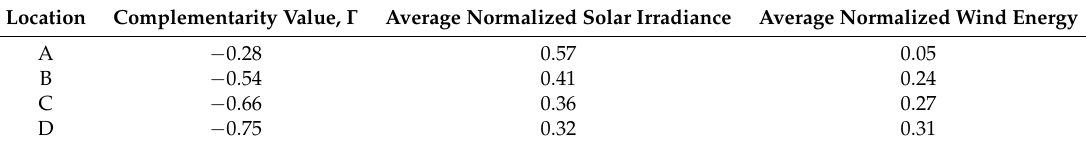
Table 2. Solar-wind characteristics at different